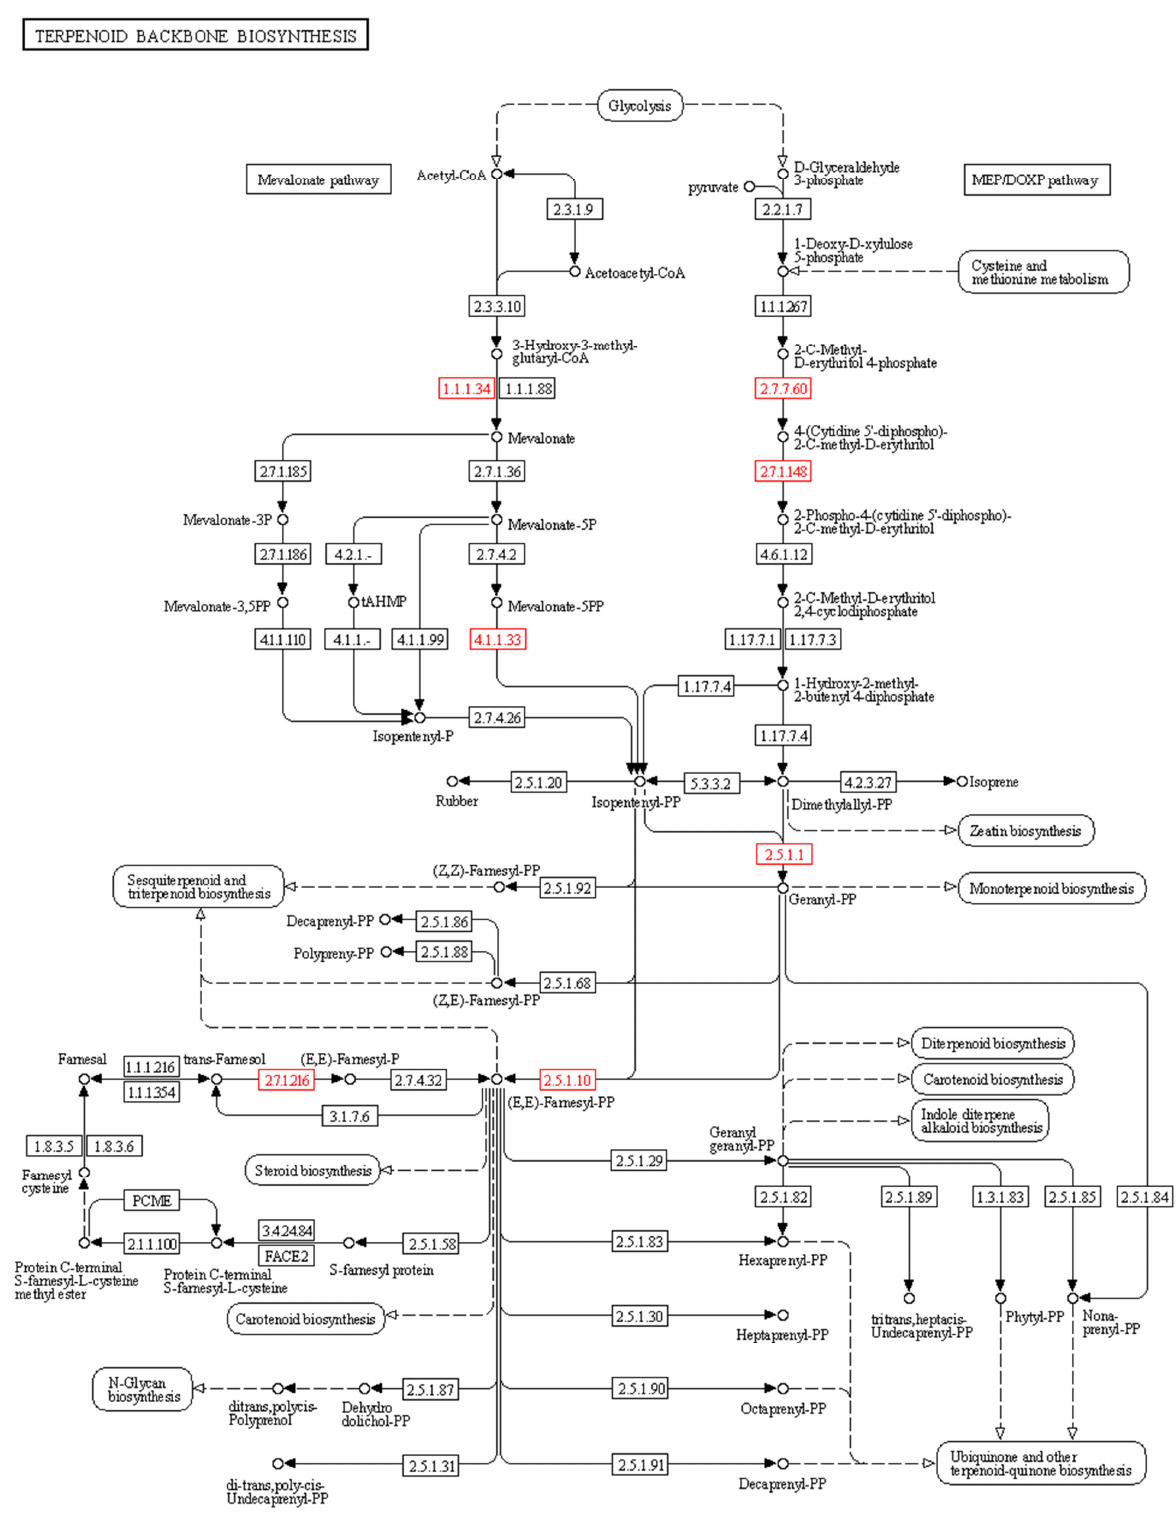
F igure 5. Key enzymes involved in terpenoid backbone biosynthesis . The identified DEGs encoding Figure 5. Key enzymes involved in terpenoid backbone biosynthesis. The identified DEGs encoding enzymes were highlighted by red colored boxes: (i) hydroxymethylglutaryl ‐ CoA reductase enzymes were highlighted by red colored boxes: (i) hydroxymethylglutaryl-CoA reductase (E1.1.1.34), (E1.1.1.34), (ii) diphosphomevalonate decarboxylase (E4.1.1.33), (iii) 2 ‐ C ‐ methyl ‐ D ‐ erythritol 4 ‐ (ii) diphosphomevalonate decarboxylase (E4.1.1.33), (iii) 2-C-methyl-D-erythritol 4-phosphate cytidy- phosphate cytidylyltransferase (E2.7.7.60), (iv) 4 ‐ diphosphocytidyl ‐ 2 ‐ C ‐ methyl ‐ D ‐ erythritol kinase lyltransferase (E2.7.7.60), (iv) 4-diphosphocytidyl-2-C-methyl-D-erythritol kinase (E2.7.1.148), (v) far- (E2.7.1.148), (v) farnesyl diphosphate synthase (E2.5.1.1), (vi) farnesyl ‐ diphosphate synthase nesyl diphosphate synthase (E2.5.1.1), (vi) farnesyl-diphosphate synthase (E2.5.1.10), and (vii) farnesol (E2.5.1.10), and (vii) farnesol kinase (E2.7.1.216). kinase